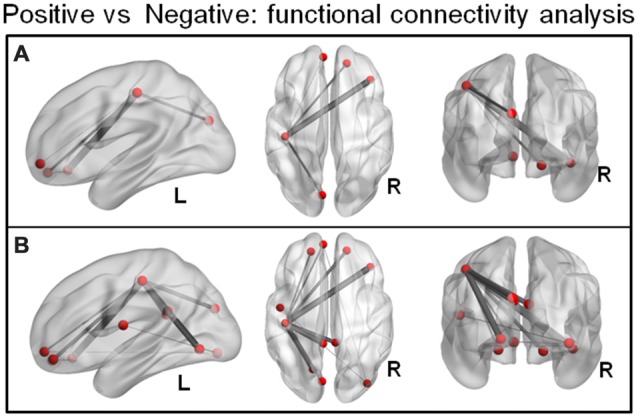
(A) Network-based statistic (NBS) on the condition-specific task-related functional connectivity matrices (positive vs. negative) revealed a sub-network (p = 0.005, FWE) comprising five interconnected brain areas that showed stronger connectivity during the positive compared to the negative regulation condition. (B) A less conservative link-based FDR correction approach (corrected p > 0.001) resulted in an extended component of 11 regions (entailing the NBS detected network).